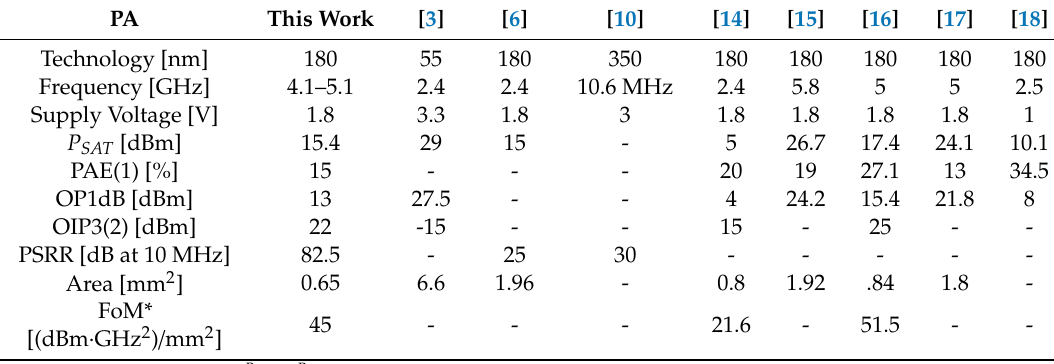
Table 1. Comparison of the power